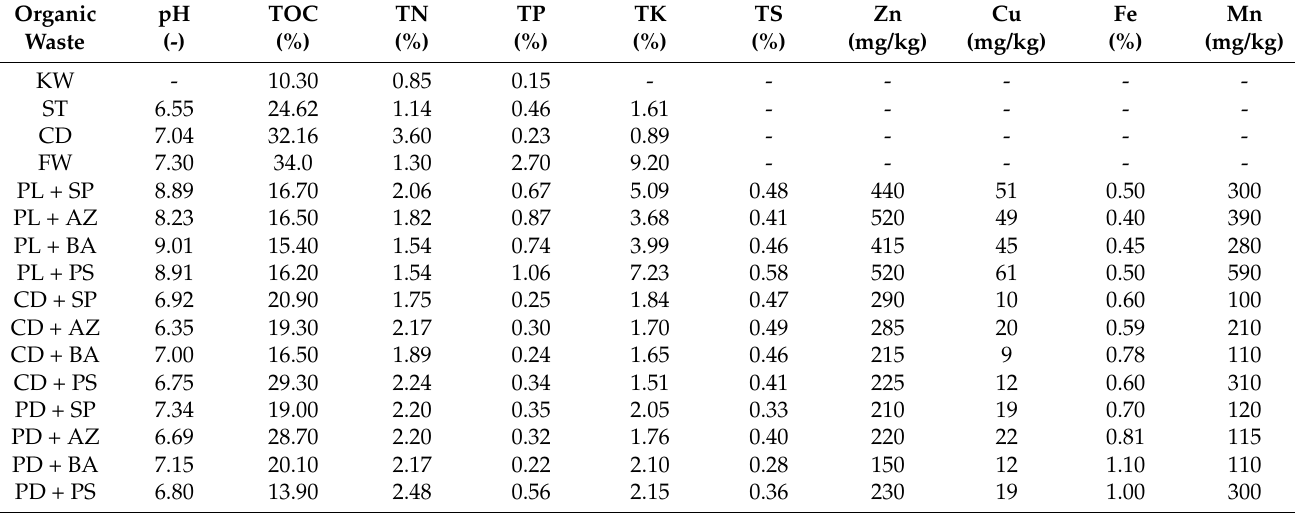
Table 1. Nutrient content of vermicompost produced from different starting materials (Source: Lim et al. (2015) [30]) and Chatterjee et al. (2021) [24]).